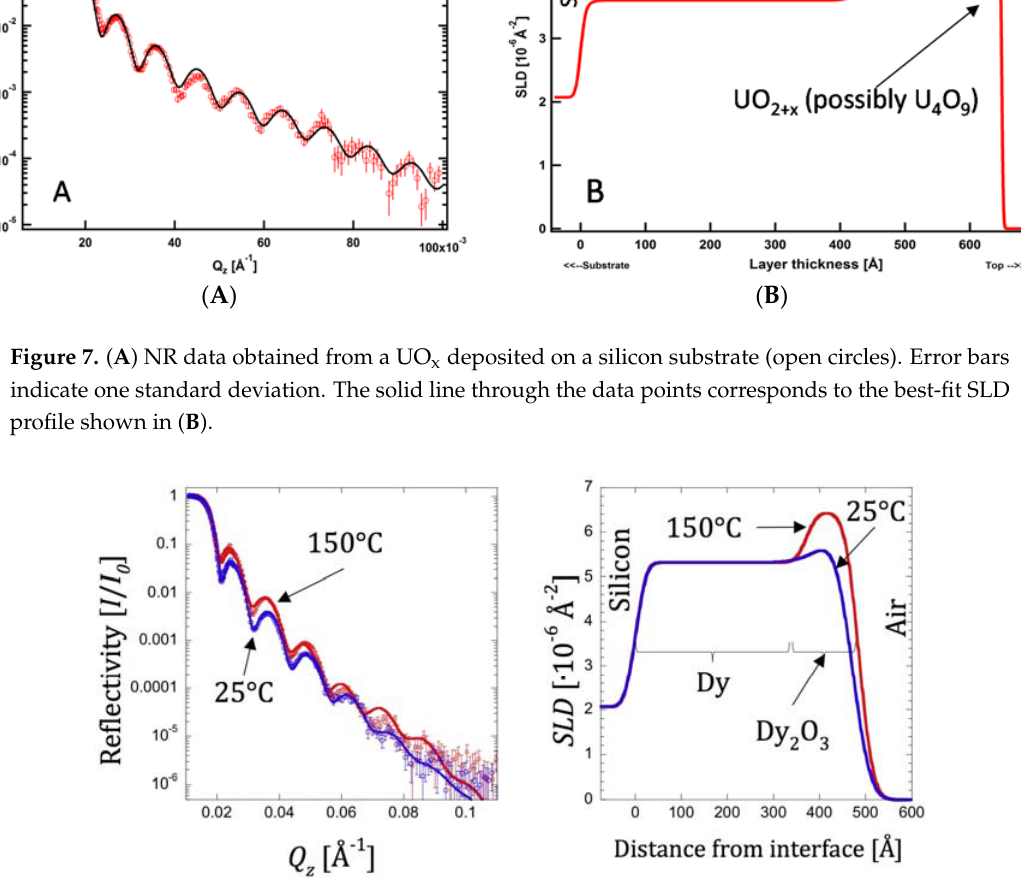
Figure 8. ( Left ) NR data (open circles) from a film of Dy covered with capping layer of Dy 2 O 3 at ambient temperature (25 °C) and after expose to air at 150 °C for ~0.5 h. Error bars in the NR measurements correspond to one standard deviation. The solid line through the data points corresponds to the best ‐ fit SLD profile shown on the ( right ).